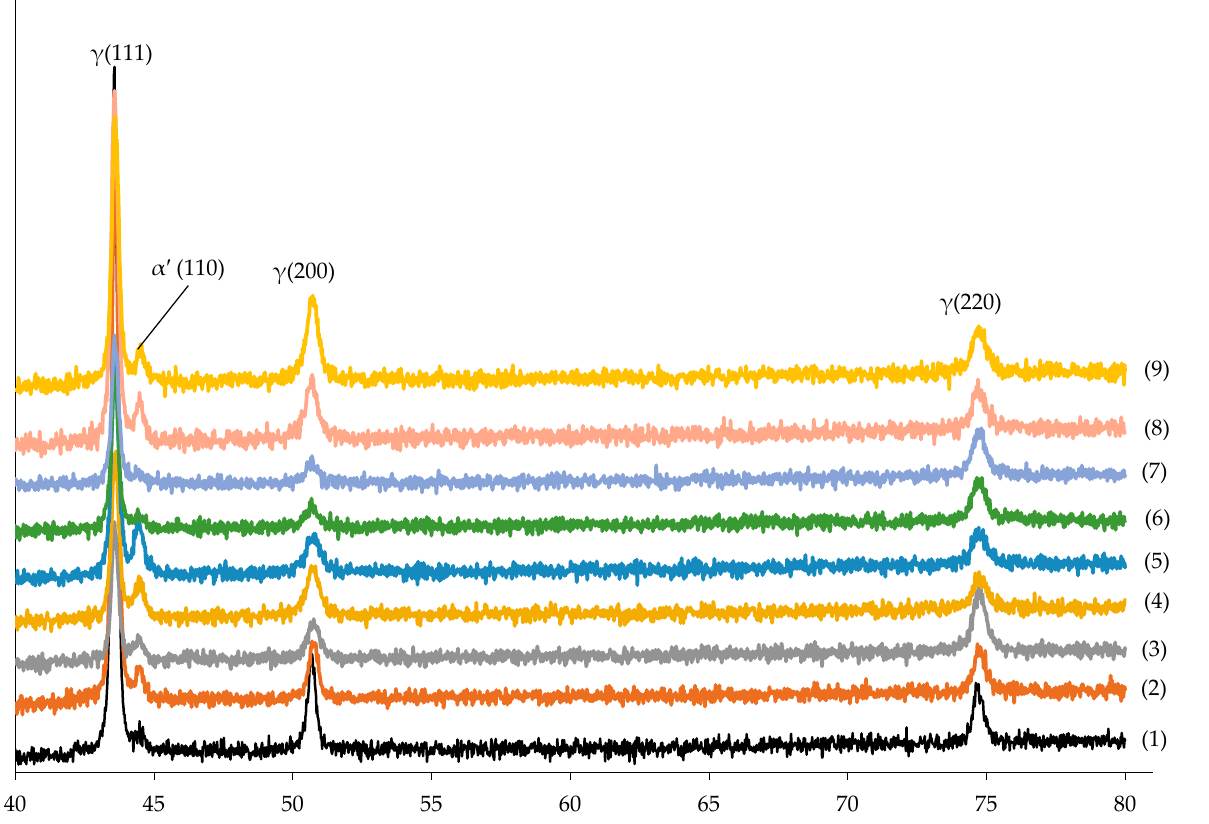
Figure 5. Results of XRD phase analysis of steel specimens in their initial state (line (1)) and after ECAP (lines (2)–(9)): (2) N = 1 at 150 °C; (3) N = 2 at 150 °C; (4) N = 3 at 150 °C; (5) N = 4 at 150 °C; (6) N = 1 at 450 °C; (7) N = 2 at 450 °C; (8) N = 3 at 450 °C; (9) N = 4 at 450 °C.